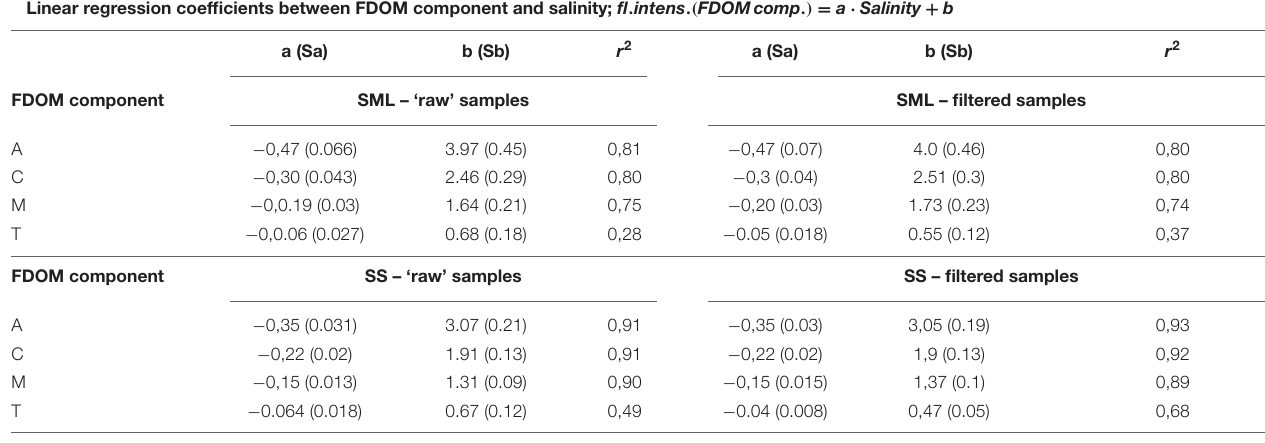
FIGURE 3 | Fluorescence intensity – a proxy of concentration of fluorophores – the main FDOM components in (A) SML and (B) SS; Percentage composition of the main FDOM components in (C) SML and (D) SS. TABLE 2 | The relation between salinity and the fluorescence intensities of FDOM components ( Figure 3 ). Linear regression coefficients between FDOM component and salinity; fl . intens .( FDOMcomp .) = a · Salinity + b